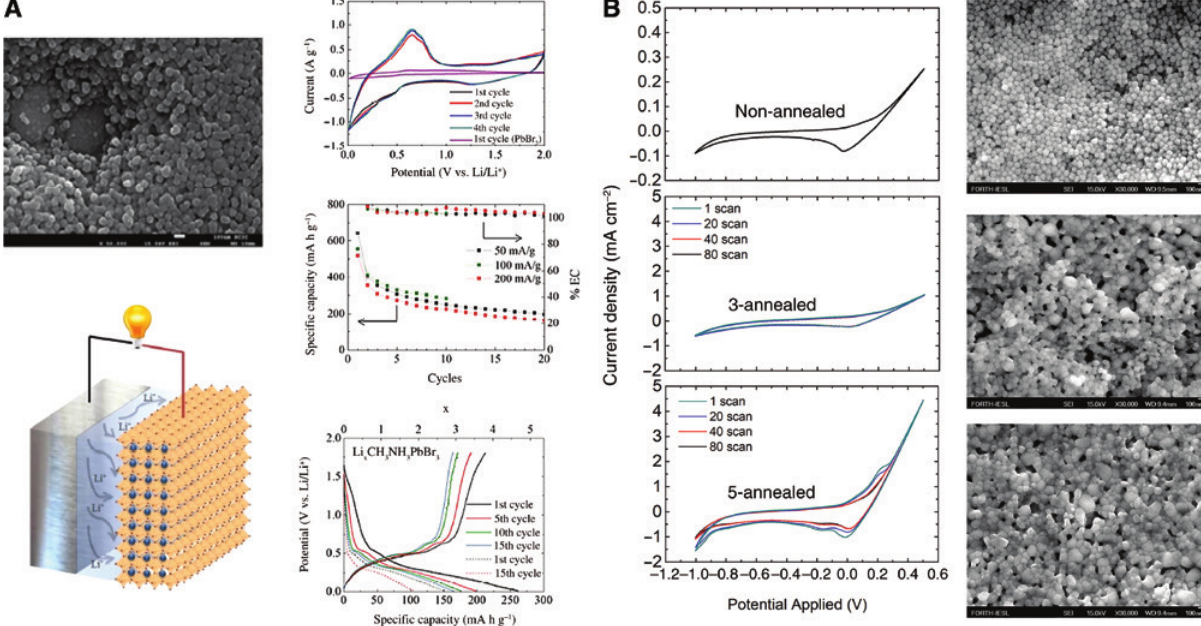
Figure 8: Metal halide perovskite nanocrystals for Li-air batteries. Electrochemical performance of the anodes consisted of (A) hybrid organic-inorganic CH NH PbBr nanocrystals of 65 nm in size, synthesized by a precipitation method combined with a heating process and 3 3 3 (B) all-inorganic metal halide, Cs PbBr nanohexagons of 100 nm in size deposited on ITO electrodes and subjected to three and five cycles 4 6 of thermal annealing. These layers are coated with a few-nanometer thin TiO layer. (A) Reprinted with permission from [31]. Copyright x (2017), American Chemical Society. (B) Reproduced from [32] with permission from the Royal Society of